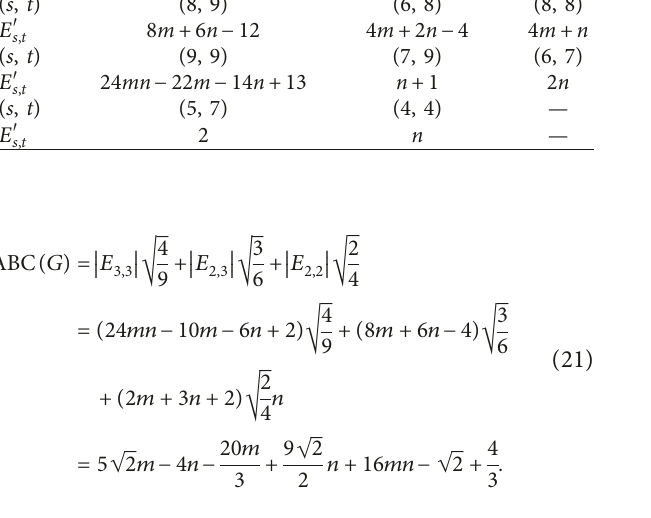
Table 4: Partition of the edge set of HC